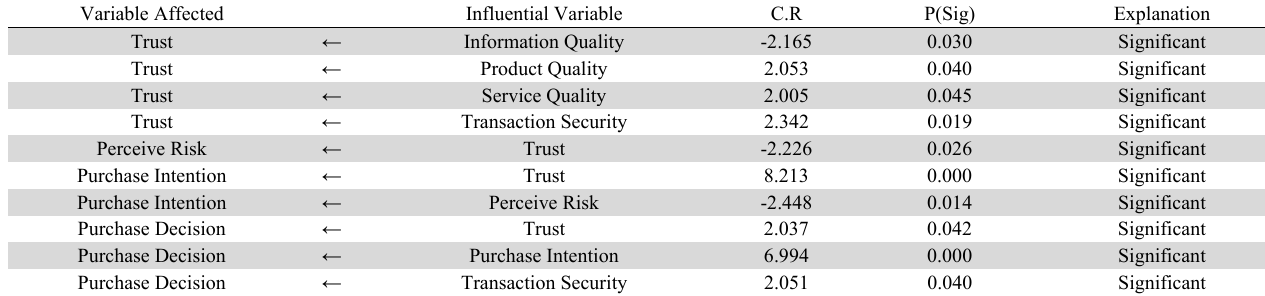
Direct Effect Variable Affected